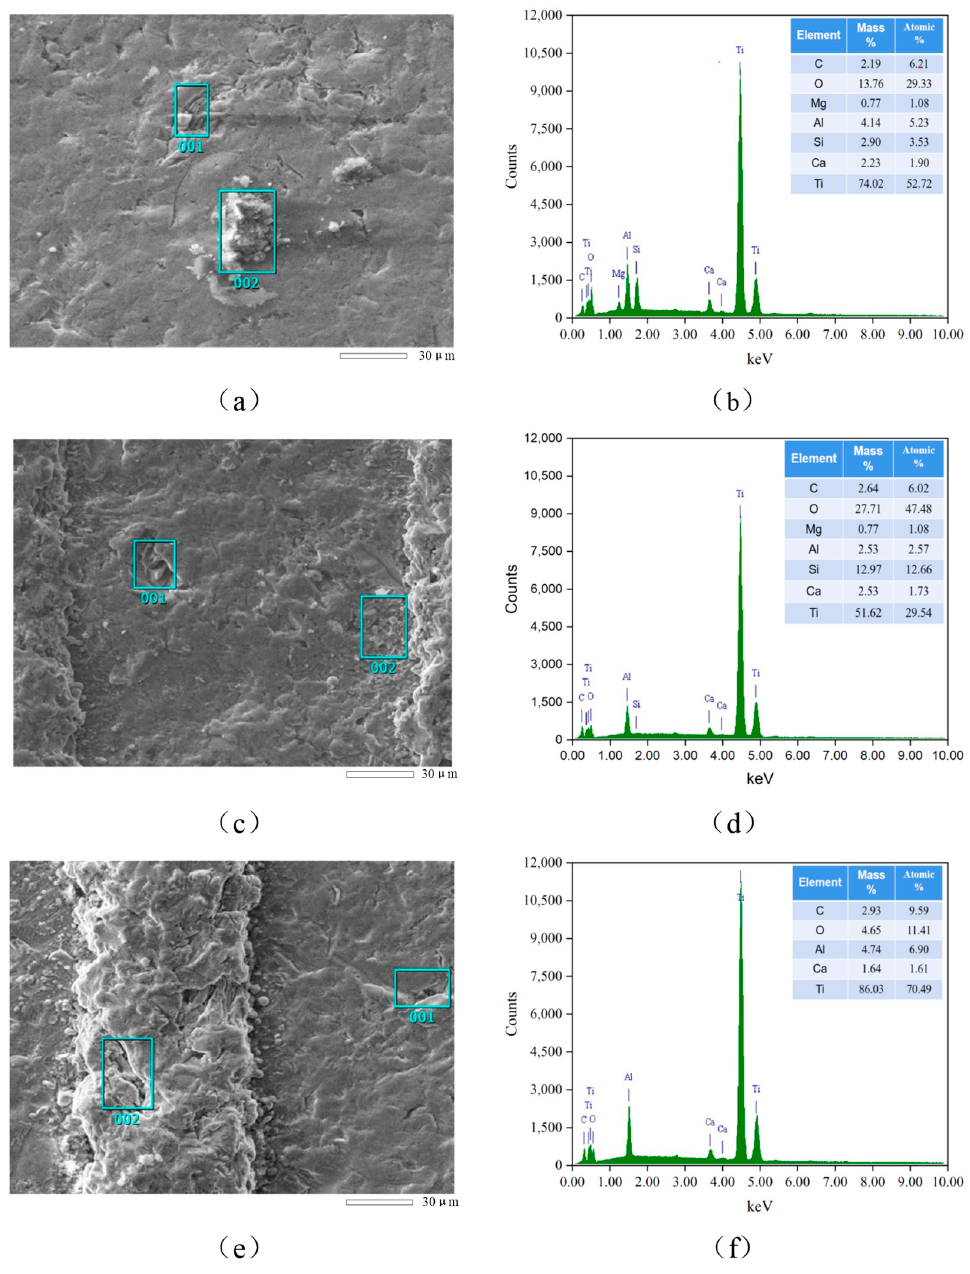
Figure 10. EDS spectra after erosion: ( a ) the sample without texture treatment; ( c , e ) superhydrophilic and superhydropho- bic surfaces with texture spacing of 150 μ m, respectively; ( b ) the spectrum in area 001 of ( a ); ( d ) the spectrum in area 001 of ( c ); ( f ) area 001 of ( e ).